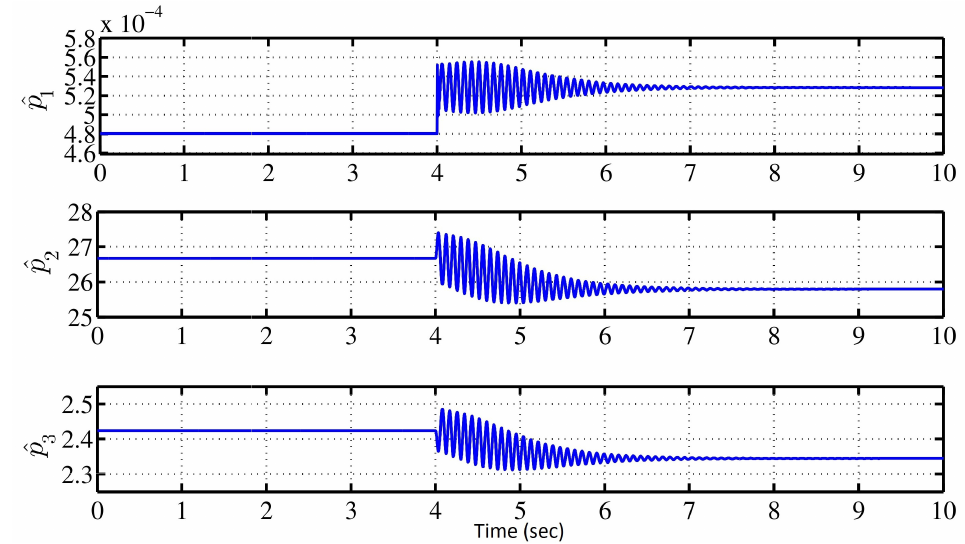
Figure 9. Response of ˆ p i , i = 1,2,3 satisfying the bounds mentioned in Table 3. The oscillations and damping are observed in the response of ˆ p i ( t ) , i = 1, 2, 3 due to